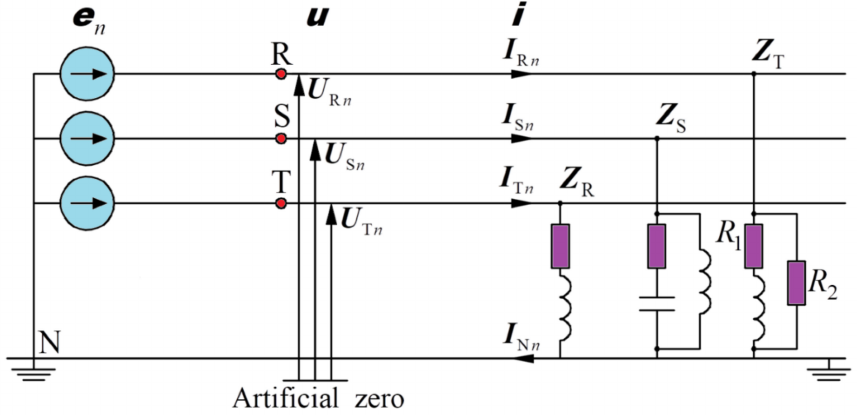
Figure 2. Three-phase four-wire system with LTI